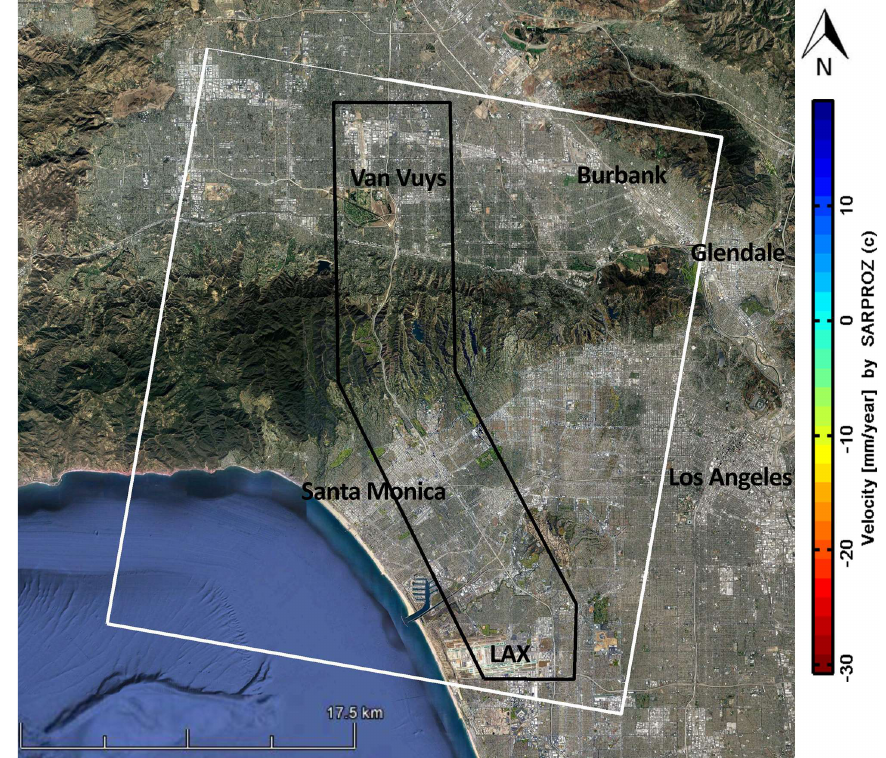
Figure 1. The study area for PSInSAR analysis, including the Sepulveda Transit